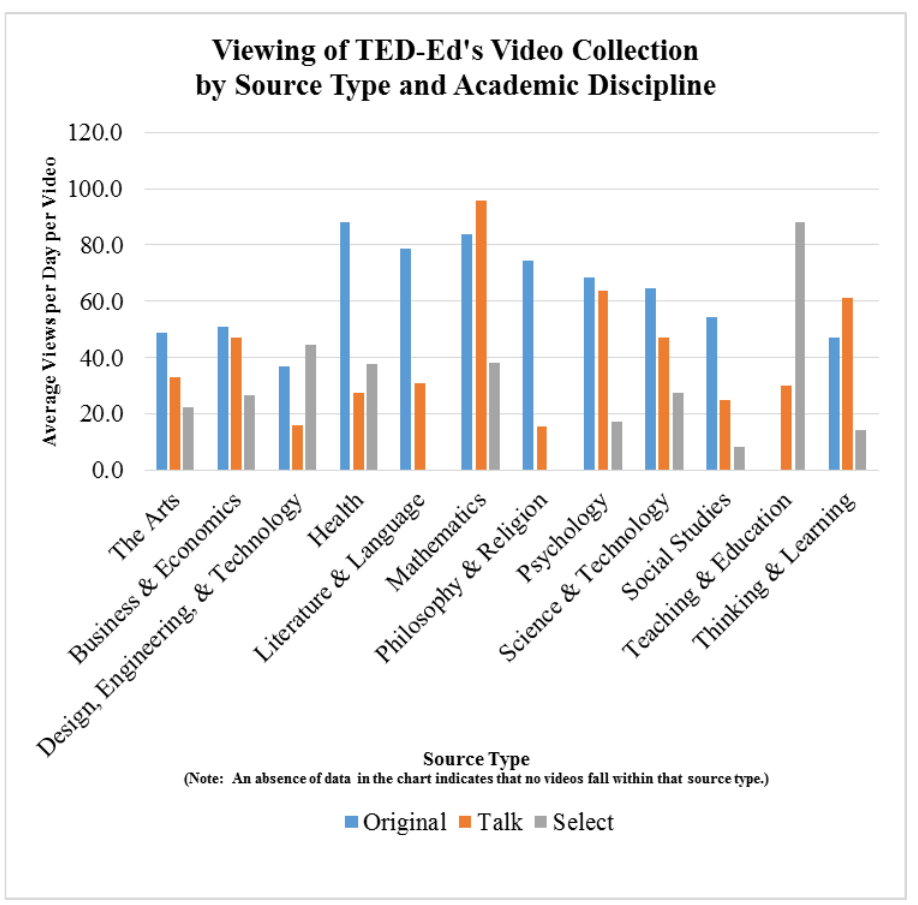
Figure 8. Viewing by source type and academic